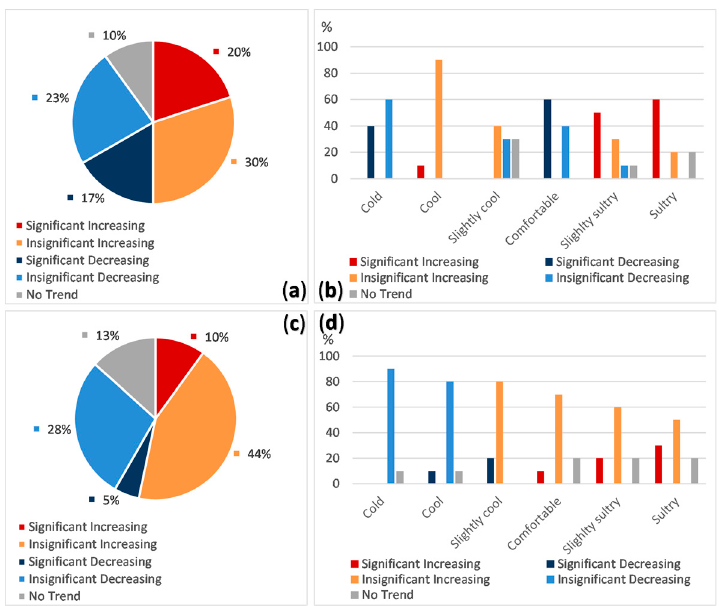
Figure 3. Trend types for TeK index: ( a ) for all data sets of FO; ( b ) by thermal sensations classes of FO; ( c ) for all data sets of DOP; ( d ) by thermal sensations classes of DOP.